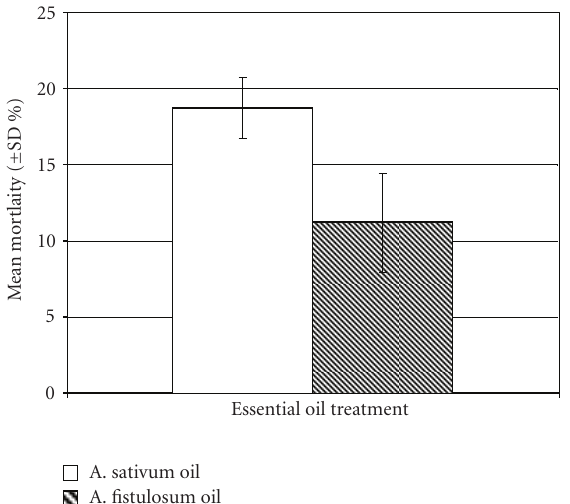
Figure 1: Fumigant toxicity of essential oil of Allium spp against C . maculatus larvae.